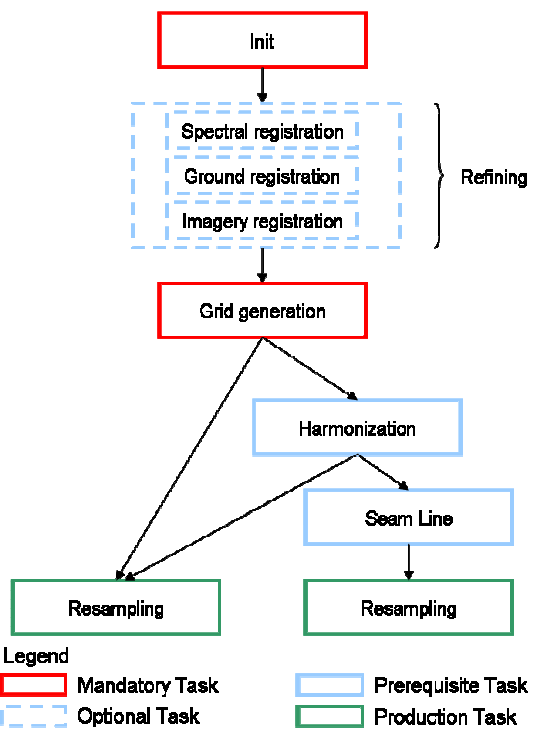
Figure 5. mosaicing processing steps